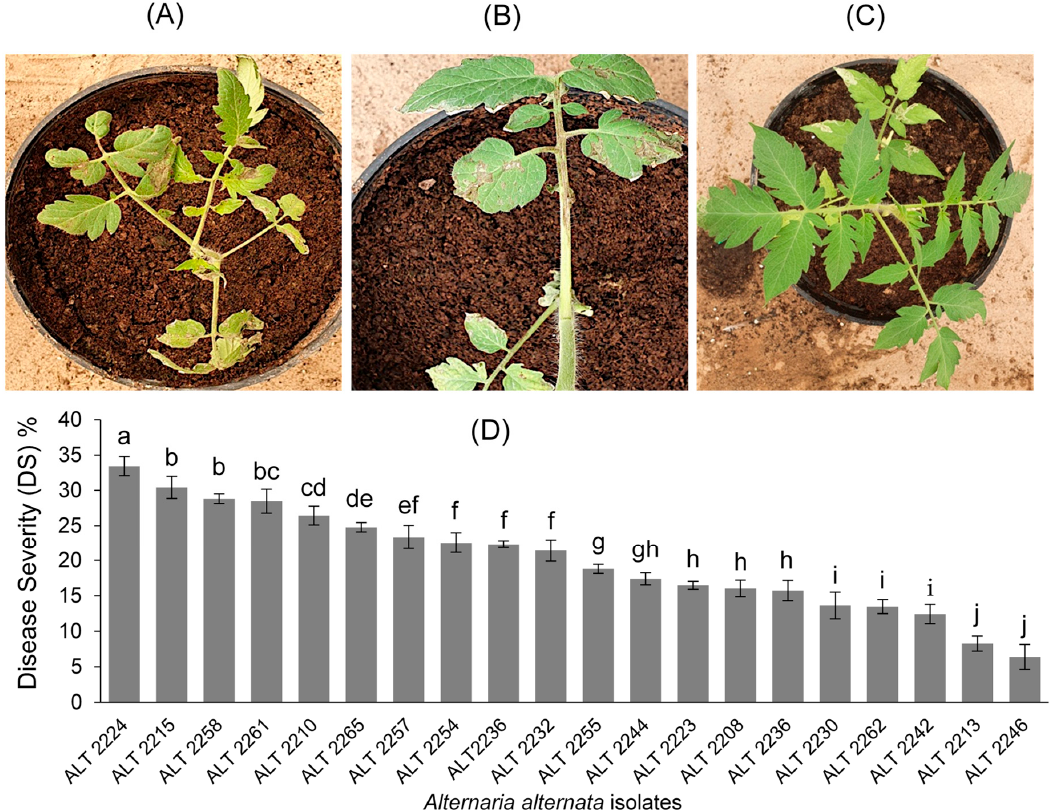
Figure 2. Disease severity (DS) ( y -axis) of A. alternata isolates ( x -axis) on tomato cv. super strain B over 30 days post-inoculation ( A – D ). Results are expressed in the mean of three replicates ( n = 5 plants each), and vertical bars represent ± standard deviation (SD). Means having the same letters are not significantly different from each other according to the least significant difference (LSD) test ( p < 0.05).